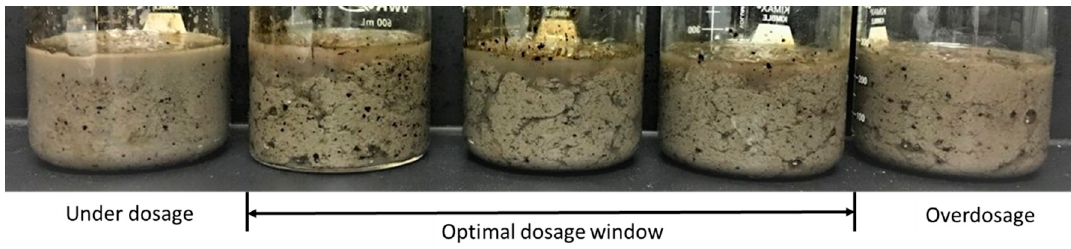
Figure 5. Photos of polymer A3338-treated FFT-1 at under dosage, optimal dosages, and over dosage.